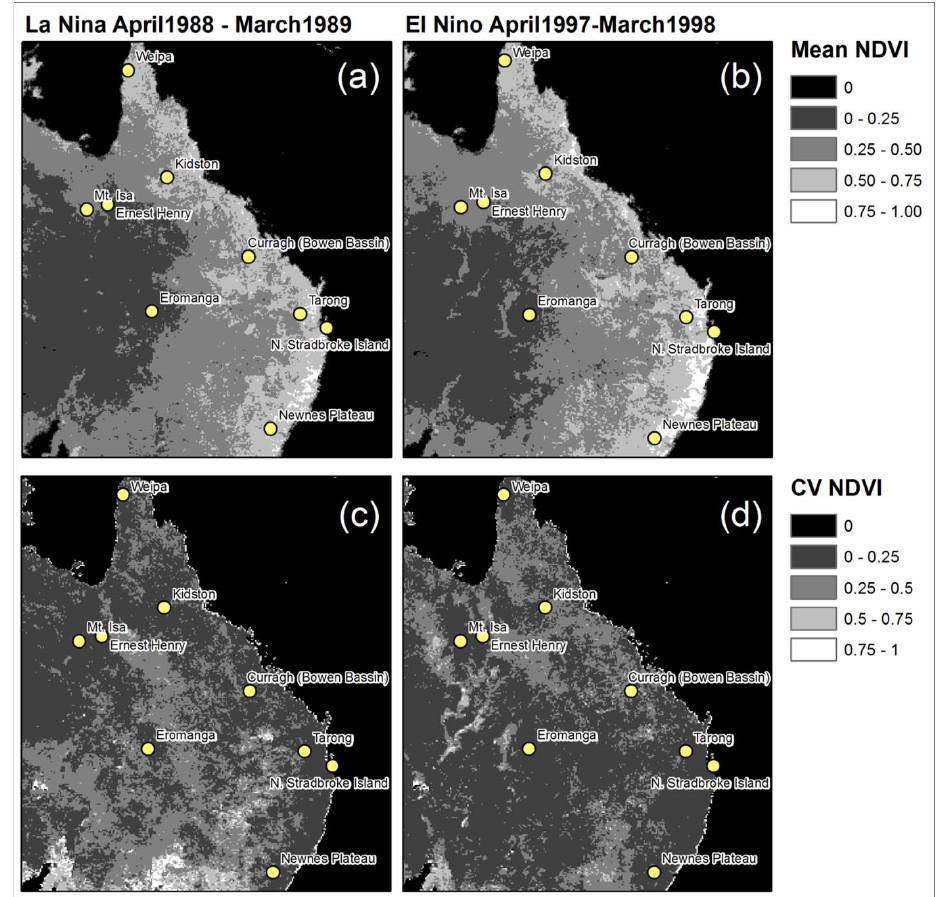
Fig. A1. Mean NDVI and coefficient of variation for the most extreme weather events across eastern Australia: ( a and c ) La Niña and ( b and d ) El